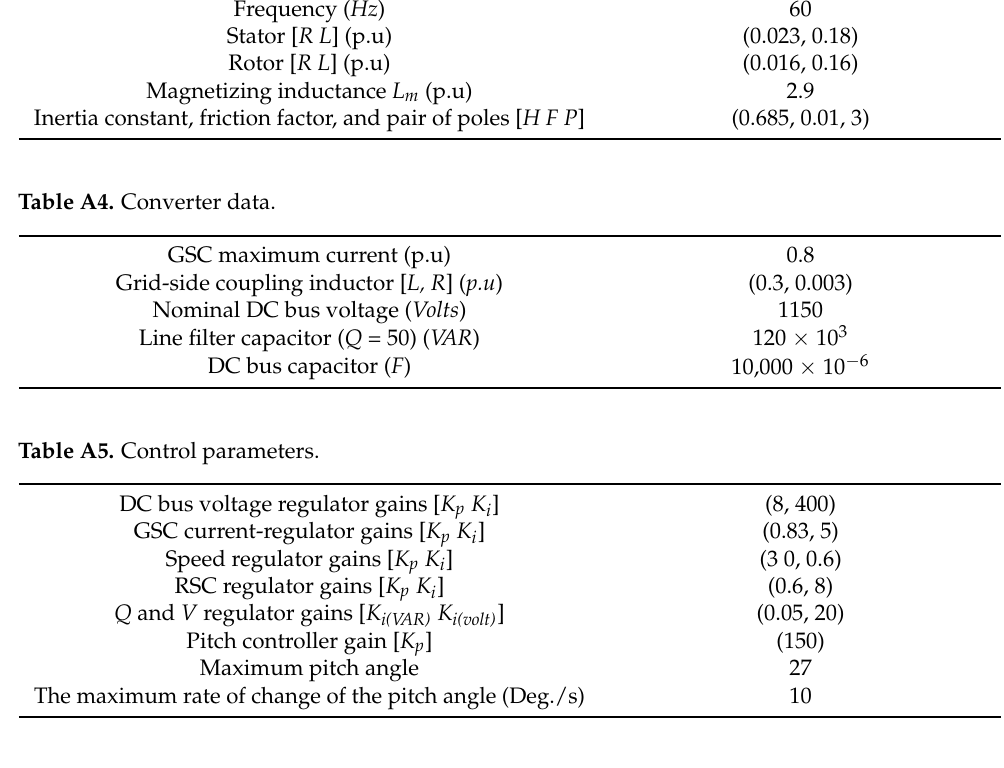
Table A6. PSO parameters.